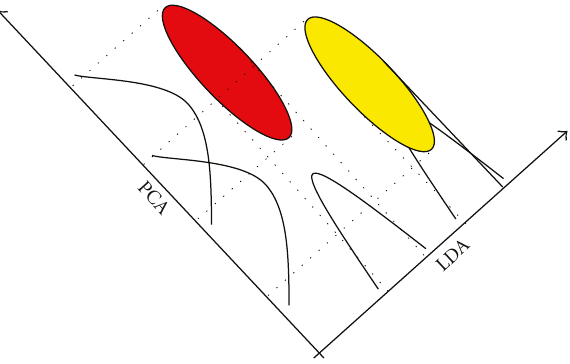
Figure 6: The projection of PCA and